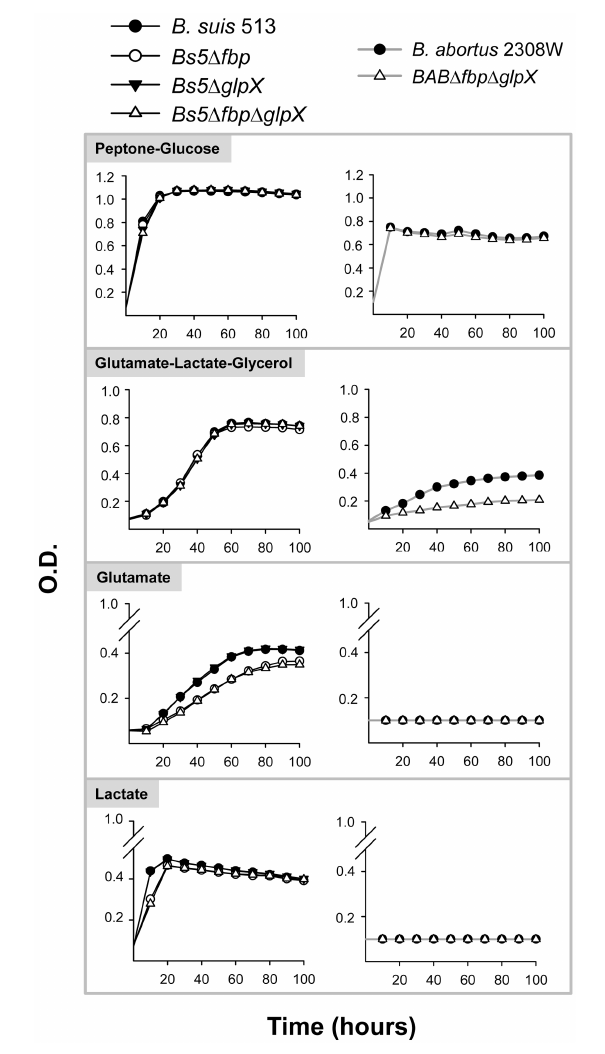
FIGURE 4 | Growth curves in peptone-glucose, glutamate-lactate-glycerol, glutamate, and lactate of B. suis 513 and mutants Bs5 (cid:49) pckA , Bs5 (cid:49) ppdK , and Bs5 (cid:49) pckA (cid:49) ppdK , and B. abortus 2308W and mutant BAB (cid:49) ppdK . Each point represents the mean ± standard error (error bars are within the size of the symbols) of an experiment performed in technical triplicates. The experiment was repeated three times with similar results.